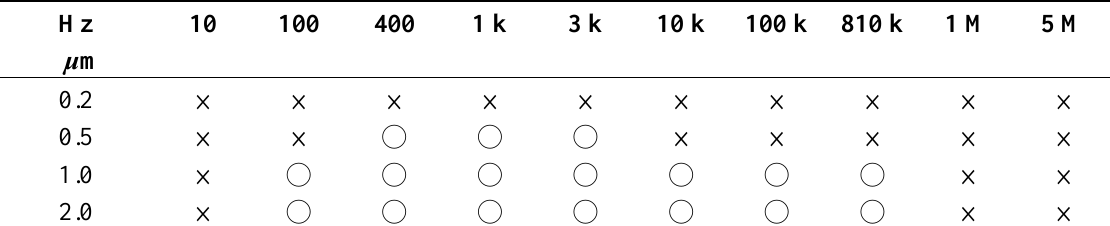
Table 2. Driving frequency versus different microparticle